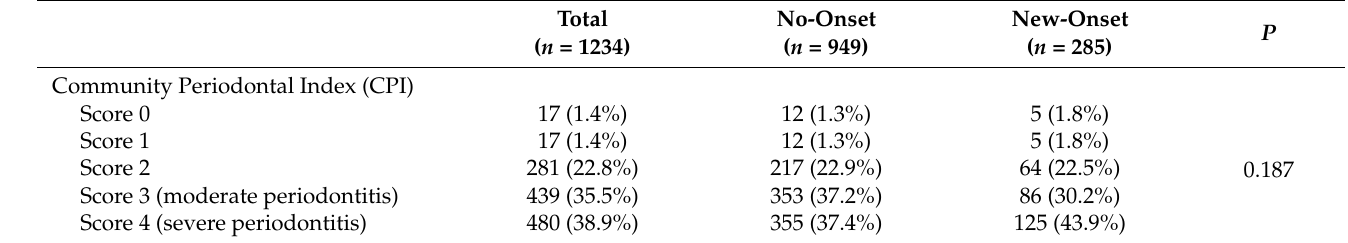
Table 2. Comparison of periodontal status at baseline with and without new-onset of oral frailty.